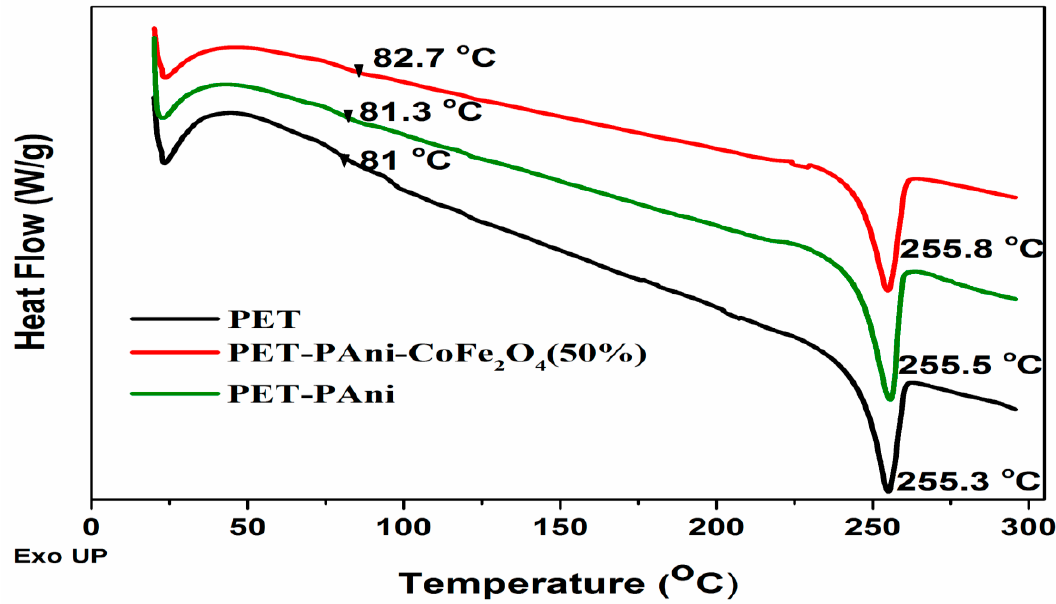
Figure 10. DSC thermograms of PET, PET-PAni and PET-PAni-CoFe 2 O 4 (50%).